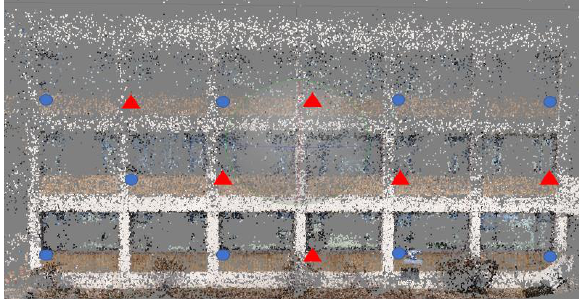
Figure 5. The red triangles are check points from the total- station, and the blue dots are the estimated GCP from method(A).